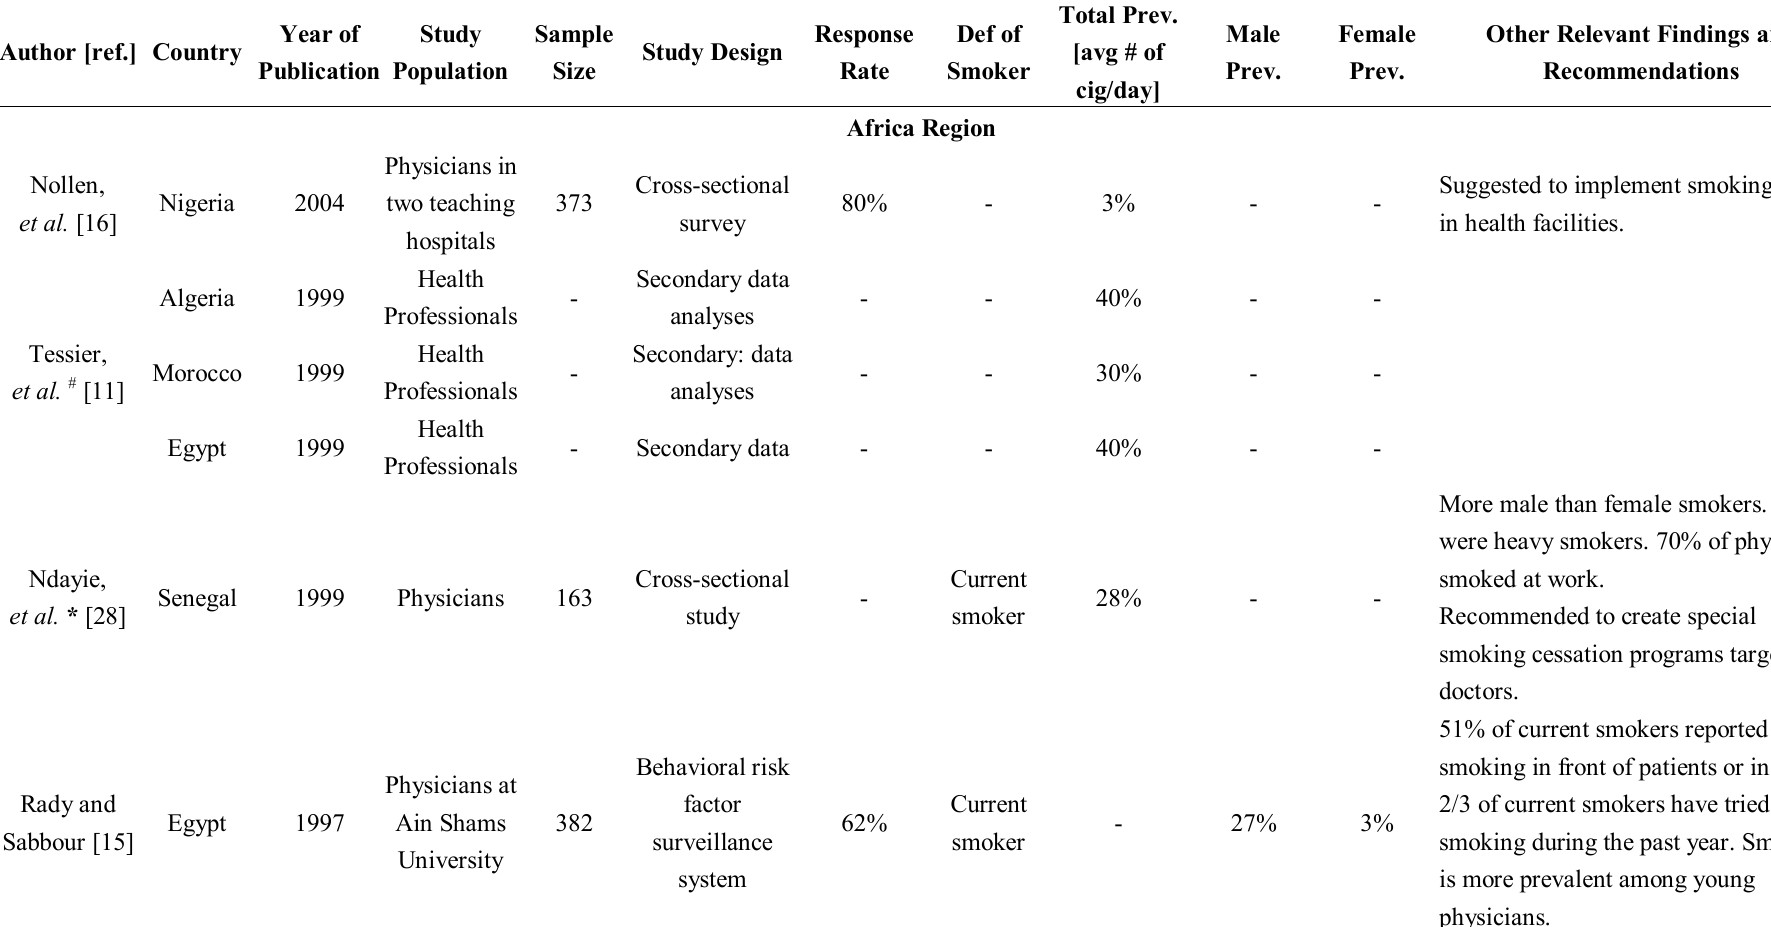
Table 1. Description of Tobacco use and cessation related surveys among physicians between 1986 and 2010 by